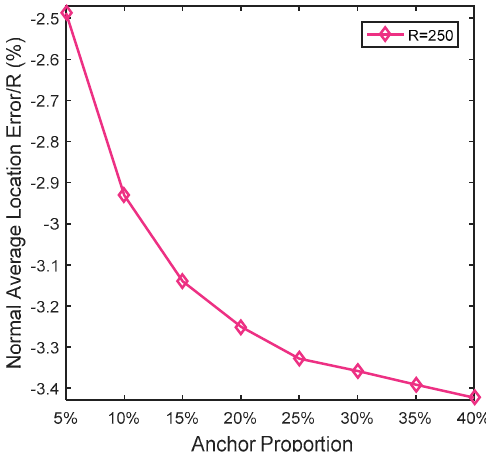
Figure 19. The influence of anchors for WSN#1.